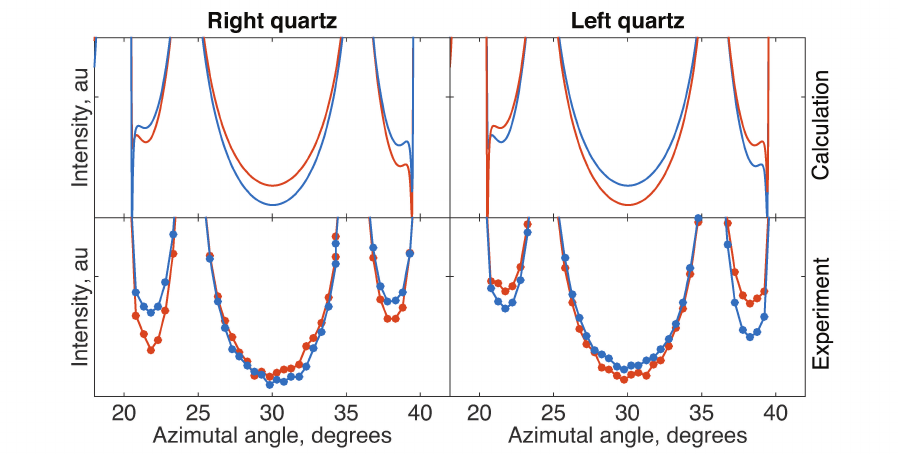
Figure 5. Difference in azimuthal dependence of the 001 reflection intensity of right and left quartz observed with right (red line) and left (blue line) circular polarization of x-ray beam at the azimuthal angle between the adjacent multiple-wave